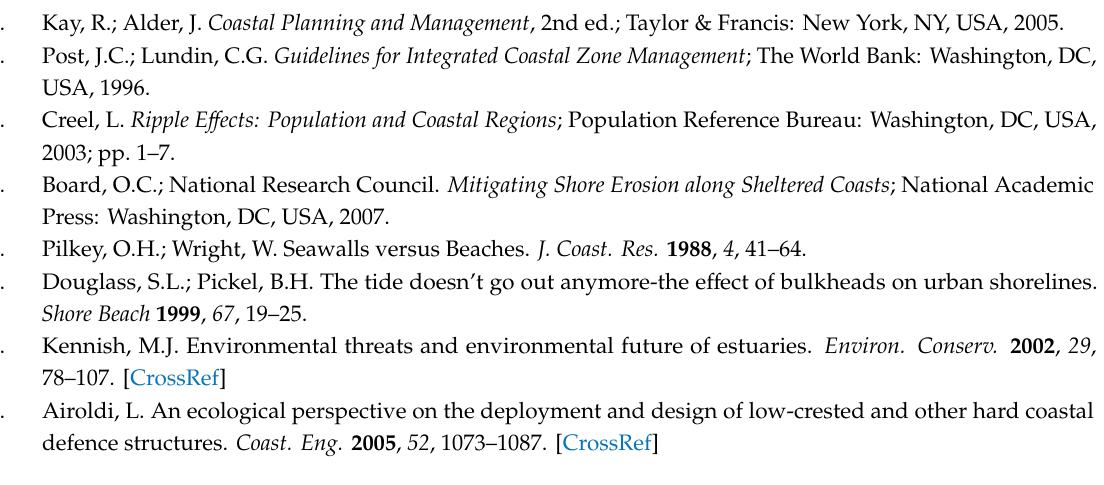
Figure S1: Plot ( a ) the longitudinal profile of the domain used in this analysis, highlighting the three di ff erent breakwater configurations. ( b ) An example of wave damping for the case with wave period = 5 s, and ( c ) linear correlations between wave period and wave height measured at the marsh boundary ( x = 200 m) for the three breakwater